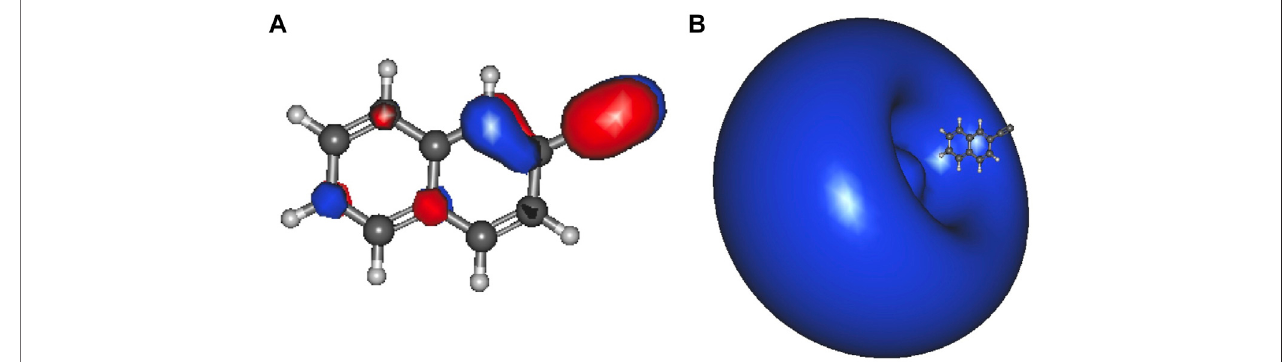
FIGURE 4 | 2-ethynylnaphthalene anion 2 a ′ HOMO (A) ;and the a ′ LUMO (B) dipole-bound orbital.